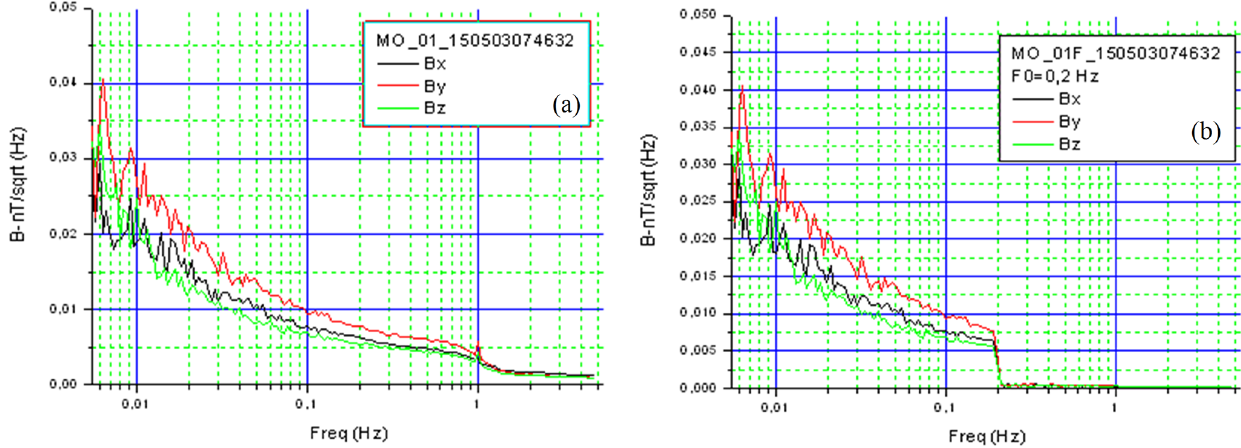
Figure 4. (a) Noise characteristics of different components of GEOMAG-02MO. (b) Noise characteristics as a result of digital filtering at F0 =